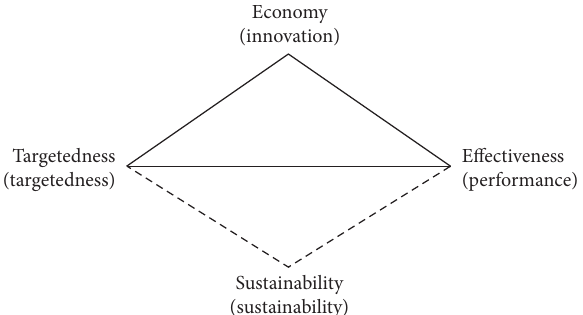
Figure 1: The 3 E +1 evaluation model of the performance of agricultural water management in targeted poverty